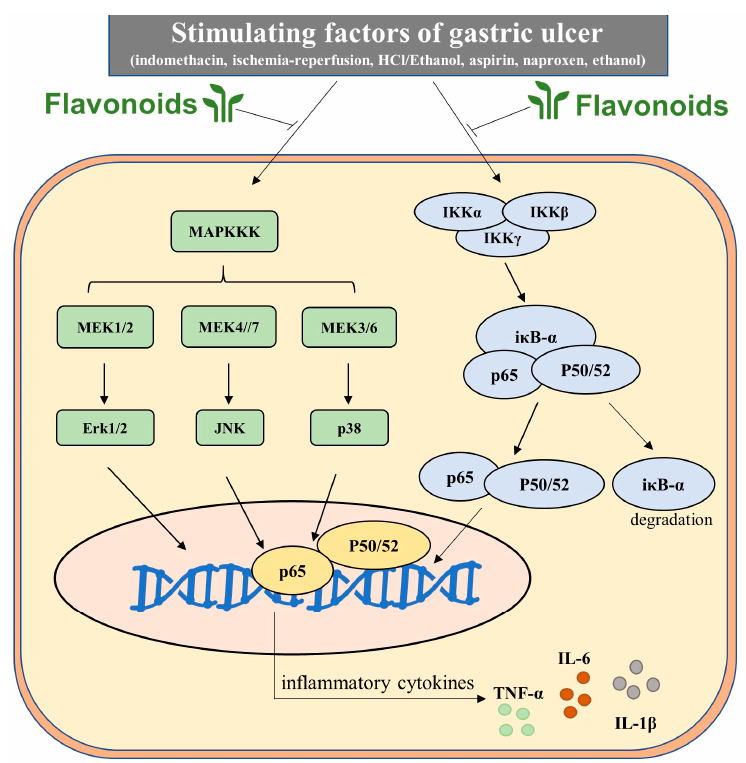
Figure 5. Flavonoids play key roles in inhibiting the occurrence and development of inflammation through the MAPK/P65 pathway by reducing inflammatory cytokine levels. In total, some factors activate MAPK upstream kinase and IKK complex (a, β , γ ), MAPKKK activates downstream cascade MEK and Erk, JNK and P38 step by step. On the other hand, the IKK complex phosphorylates I κ B proteins and frees NF- κ B/Rel complexes to translocate to the cell nucleus. The activated MAPK downstream kinases and NF- κ B p65/p50/52 would increase the expression of pro-inflammatory TNF- α , IL-1 β , and IL-6 and augment anti-inflammatory IL-10. Flavonoids would regulate kinases involved in these two signaling pathways and inhibit pro-inflammatory cytokines to ameliorate inflammatory symptoms in peptic ulcer.